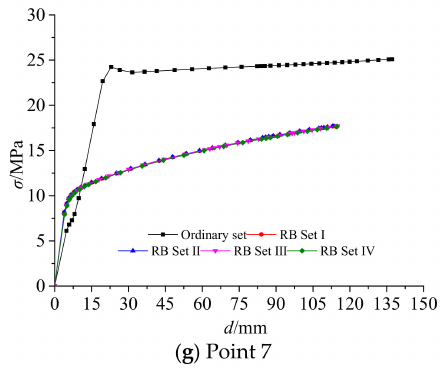
Figure 19. The stress-strain curve of the RB